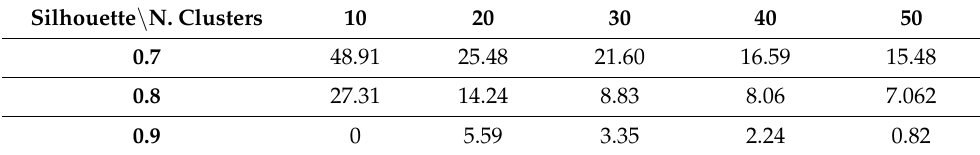
Table 13. Clustering performance in terms of silhouettes using original data. Silhouette \ N. Clusters